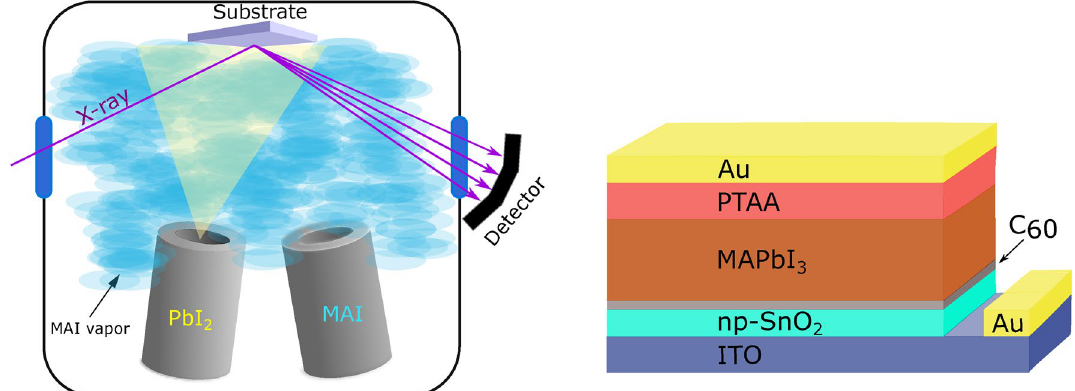
Figure 1. Left: sketch of the vacuum chamber used for the phase analysis with in situ XRD during the deposition of MAPbI 3 by co-evaporation. The evaporation of MAI leads to an overall increase of the global chamber pressure, which in turn was used to control the incorporation of MAI into the film. Right: sketch of the solar cell architecture used in this